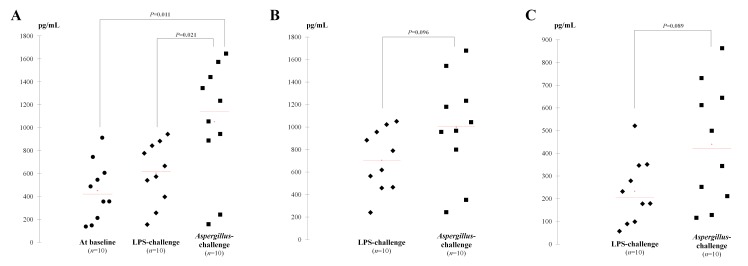
Scattergrams showing distribution of the individual measurements of Wnt1 inducible signaling pathway protein 1 (Wisp-1) and basic fibroblast growing factor (bFGF) proteins in blood or in lung from the rat experimental model.A–Wisp-1 measurements in blood from 10 rats of each group. According to the kit instructions, the detection ranged from 100 to 2,500pg/mL; B–Wisp-1 measurements in supernatants of the lung homogenates from 10 rats of each group; C–Basic FGF measurements in supernatants of the lung homogenates from 10 rats of each group. The concentration gradients of the kit standards render a theoretical kit detection range of 2–500 pg/mL through a standard curve using a vial of rat bFGF at 500 pg/mL as initial concentration. Abbreviation: LPS, bacterial lipopolysaccharide.